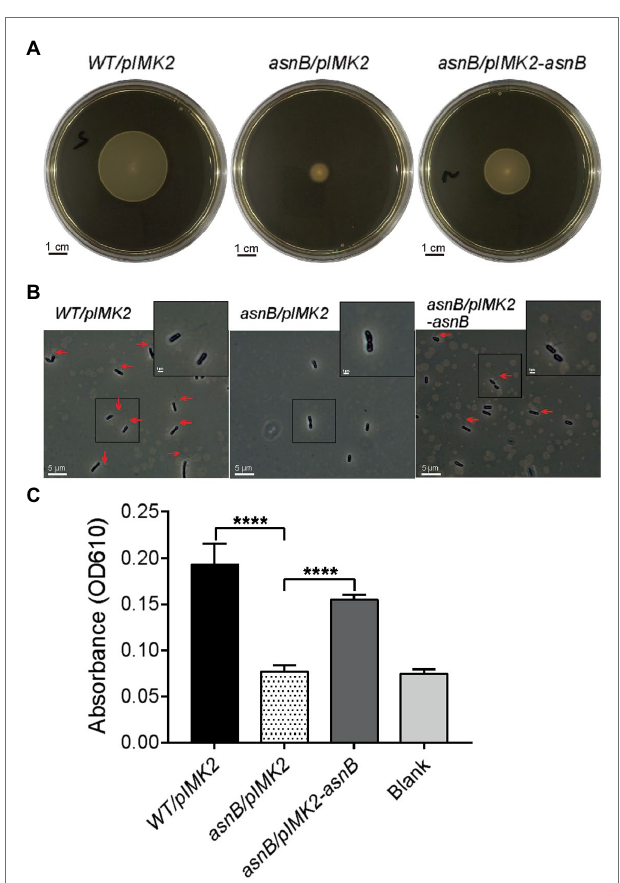
FIGURE 3 | Flagellation, motility, and biofilm formation of the L. monocytogenes asnB mutant. (A) Swimming motility at 30 ° C of WT/pIMK2 , asnB/pIMK2 , and asnB/pIMK2-asnB stabbed in 0.2% BHI agar. Images are representative of three independent tests. (B) Detection of flagella by flagellar staining and phase contrast microscopy, in the same strains. For each strain, more than 300 cells from three independent analyses were observed, and flagella were never seen in the asnB mutant. (C) Biofilm-forming capacity of the same strains in a 96-well polystyrene microplate determined by crystal violet staining. The data represent mean ± SD; n = 4; ****, p < 0.0001 by two- tailed student’s t